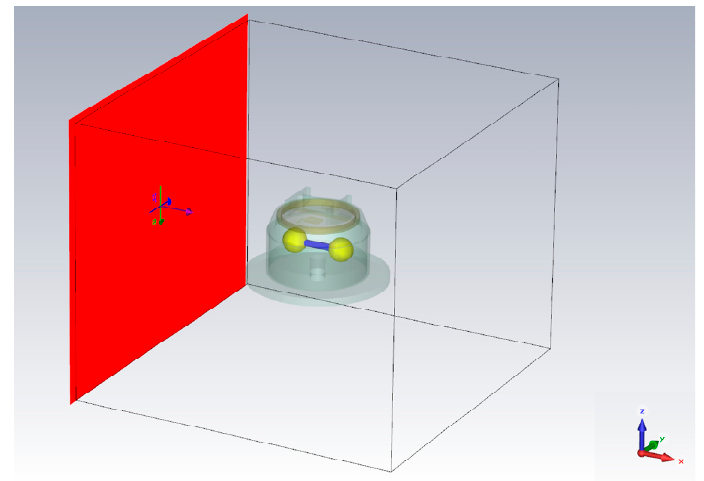
Figure 7. The incident direction of UWB EMP.